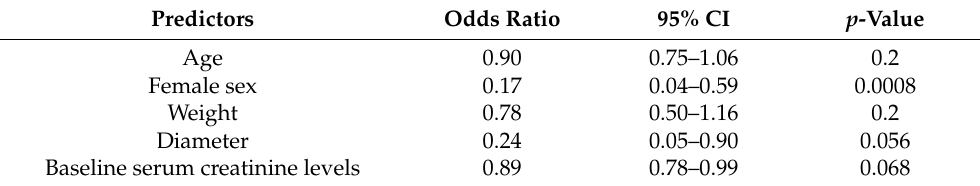
Table 3. Multivariate predictors of passage of